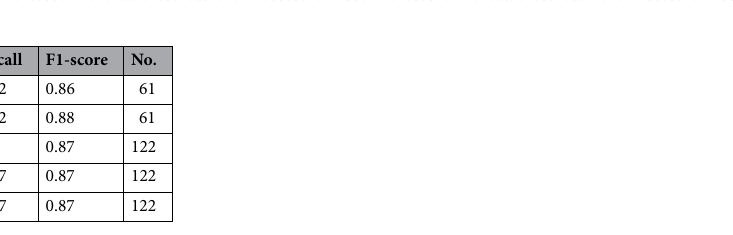
Table 5. The classification results of only CNN using Leaky ReLU. No. indicates the number of samples.